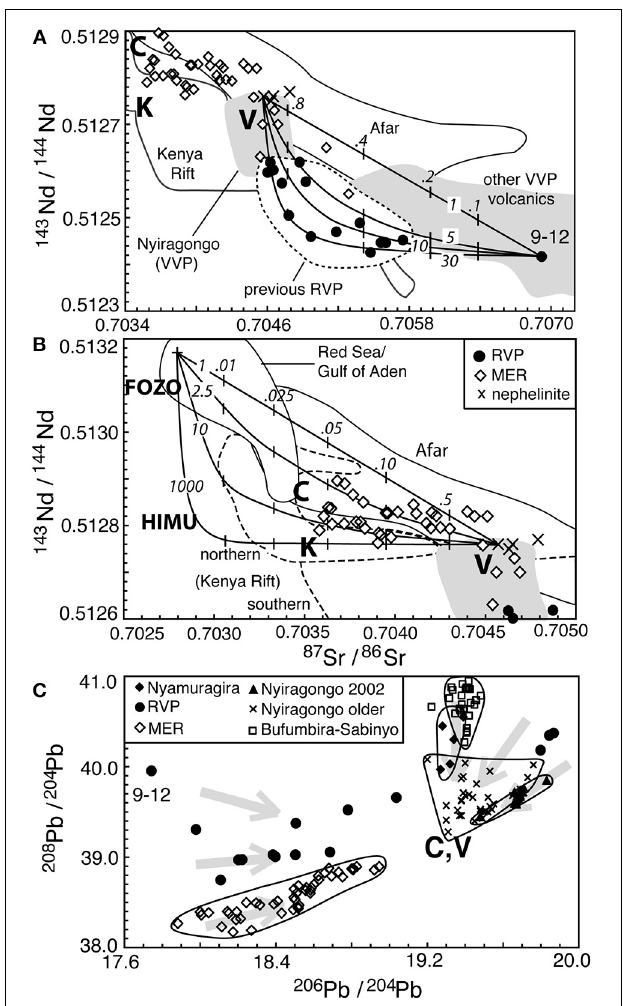
FIGURE 5 | (A) Simple mixing model based on the 143 Nd/ 144 Nd and 87 Sr/ 86 Sr isotopic composition of Rungwe (RVP) samples. Samples conform with curved mixing lines between sample TAZ09-12 ( 87 Sr/ 86 Sr = 0.70692; Sr = 907ppm; 143 Nd/ 144 Nd = 0.512417; Nd = 44ppm) and one of the Nyiragongo melilite-bearing nephelinites ( 87 Sr/ 86 Sr = 0.70457; Sr = 2421ppm; 143 Nd/ 144 Nd = 0.51276; Nd = 117.4ppm) (Vollmer and Norry, 1983b). Curvatures of the mixing lines [r = (Nd/Sr Taz09 - 12 )/(Nd/Sr nephelinite )] shown range from 1 to 30. Short bars along mixing lines represent increments of plume V proportions. (B) Mixing model to explain the 143 Nd/ 144 Nd and 87 Sr/ 86 Sr isotopic composition of plume-related lavas in the MER and northern Kenyan Rift. The bulk of MER samples (Trua et al., 1999; Rooney et al., 2012) conform with curved mixing lines between the high 143 Nd/ 144 Nd and low 87 Sr/ 86 Sr Middle to Late Proterozoic lithospheric mantle (e.g., Chazot and Bertrand, 1993; Lucassen et al., 2008), which is ∼ similar to one of the depleted samples from the local lithospheric mantle beneath the Gulf Aden ( 87 Sr/ 86 Sr = 0.702796; Sr = 144.3 ppm; 143 Nd/ 144 Nd = 0.51317; Nd = 7ppm) (Rooney et al., 2012), and the same Nyiragongo melilite-bearing nephelinites used in plot A ( 87 Sr/ 86 Sr = 0.70457; Sr = 2421 ppm; 143 Nd/ 144 Nd = 0.51276; Nd = 117.4ppm) (Vollmer and Norry, 1983b). Curvatures of the mixing lines [r = (Nd/Sr nephelinite )/(Nd/Sr local asthenosphere )] shown range from 1 to 1000. The convex-down nature of the mixing lines fits the range and scatter of the bulk of the MER lavas and mobile belt (ML) mafic lavas from the Kenyan Rift (Rogers et al., 2000). Short bars along mixing lines represent increments of proportions of plume V. The